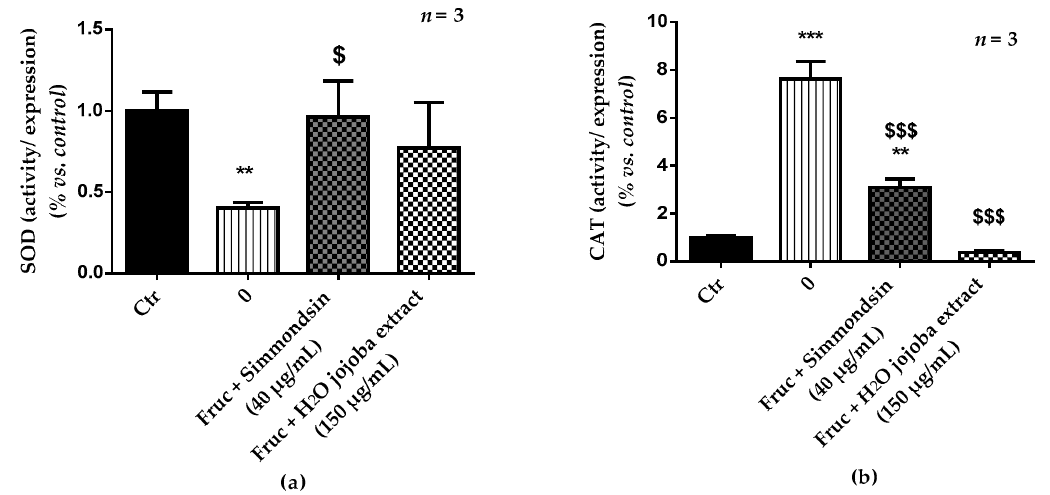
Figure 5. Effect of the aqueous jojoba seed extract and pure simmondsin on superoxide dismutase (SOD) ( a ) and catalase (CAT) ( b ) ratio (activity/expression). Each value represents the mean ± standard error of the mean (SEM) of three independent experiments in triplicate. * p < 0.05, ** p < 0.01, *** p < 0.001, compared to untreated cells, $ p < 0.05, $$$ p < 0.001, compared to fructose-treated cells.